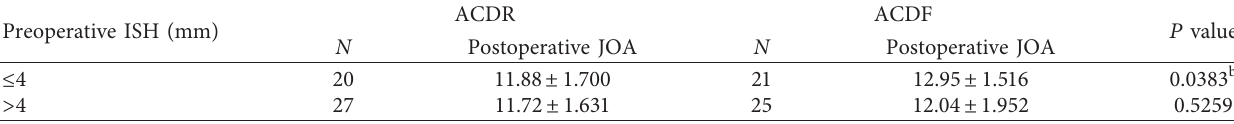
Table 5: Preoperative ISH and postoperative JOA outcome a . Preoperative ISH